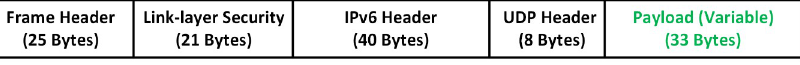
Fig 5. IEEE 802.15.4 MAC frame headers and payload field.